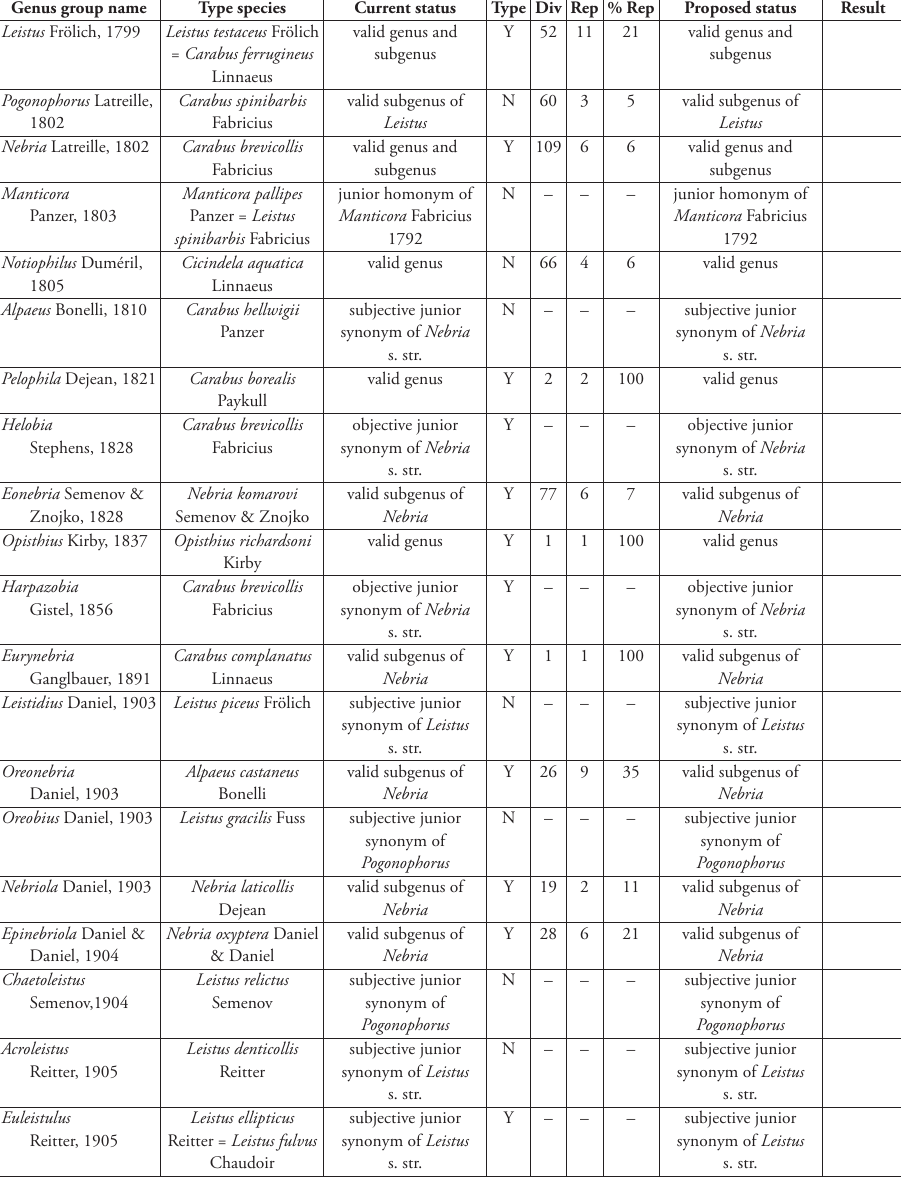
Table 1. Genus-group names in supertribe Nebriitae. All published genus-group names are represented in this list in order of publication and include author, year of publication, type species and current taxo- nomic status (Ledoux and Roux 2005; Lorenz 2005). The “Type” column indicates if the type species for the name is represented (Y) or not (N) in our taxon sample. The “Div” column lists the number of known species for each valid genus-group name. The “Rep” column indicates how many species-group taxa are represented in our taxon sample, and the “% Rep” column indicates what percentage of the known di- versity is represented in our taxon sample. The “Proposed status” column indicates the appropriate status of the names based on the results of our study, with any changes in status noted in the “Result”